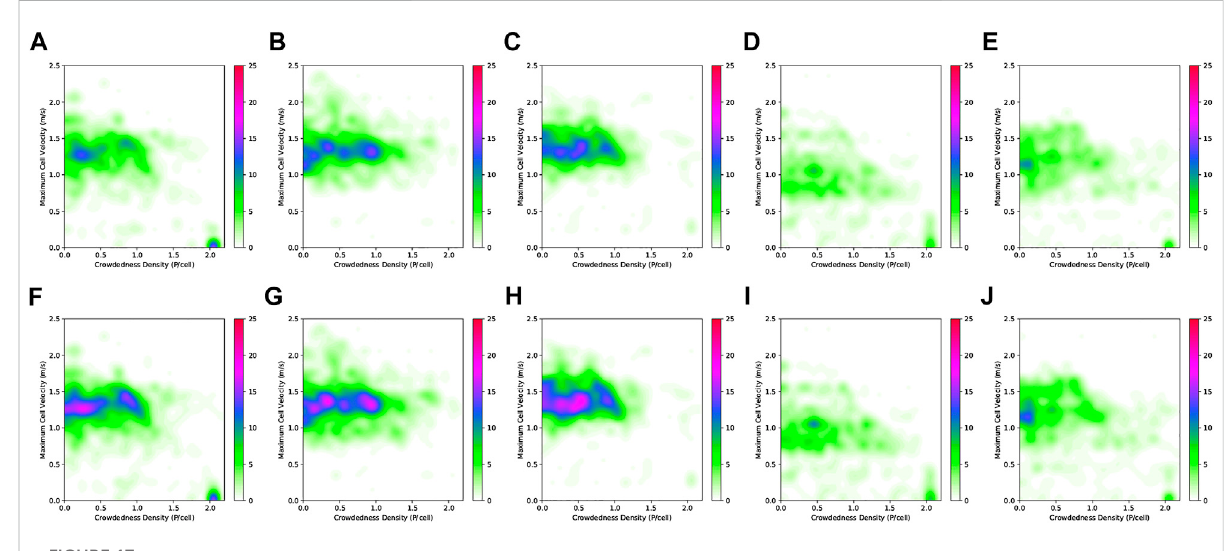
FIGURE 17 HistogramsofFundamentalDiagramsof fl owofthelongcorridor (A – E) andhall (F – J) areasoftheATCenvironment.Column-wise fromleftto right: time-points 1 –